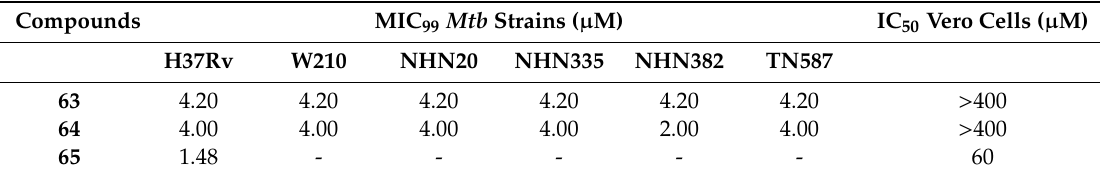
Table 14. Antimicrobial activities of benzimidazoles 63, 64 , and 65 against M. tuberculosis strains.